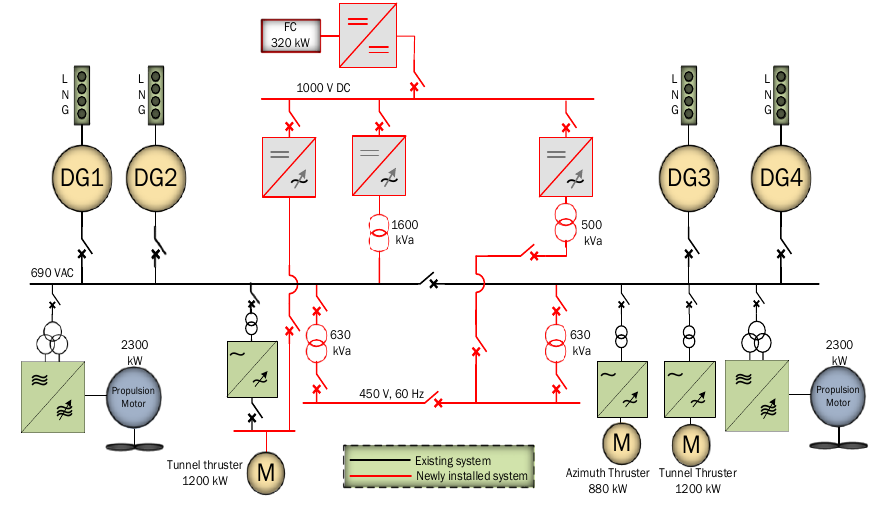
Figure 10. Fuel cell integration in Viking Lady [67]. Table 3. Summary of Fuel Cell based vessels and